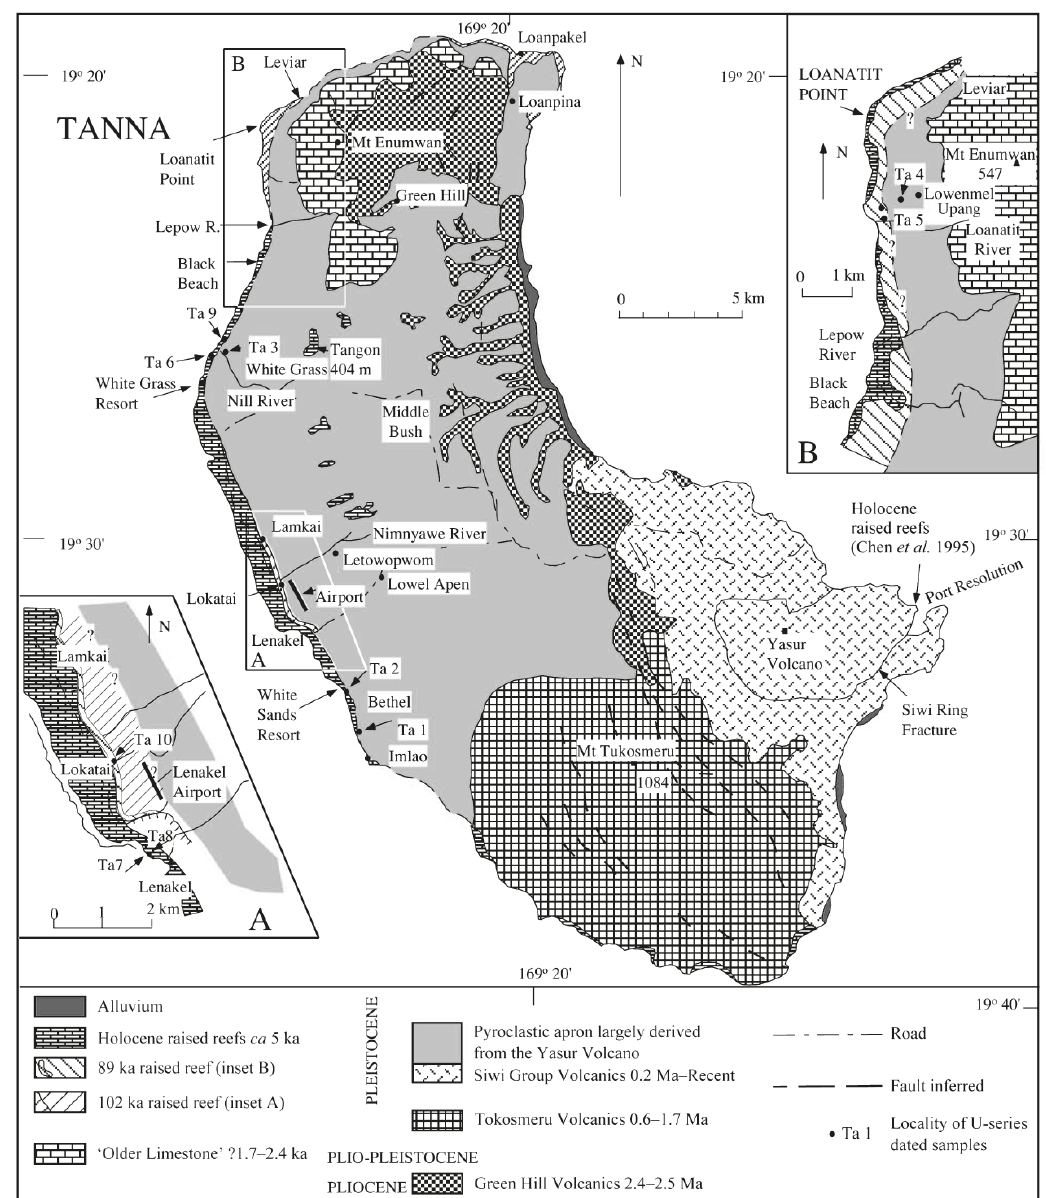
Figure 26. Raised reef terraces on Tanna Island (from Neef and Hendy, 1988, and Neef et al., 2003).